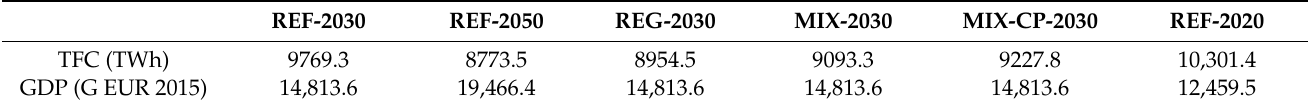
Table 1. TFC and GDP in every